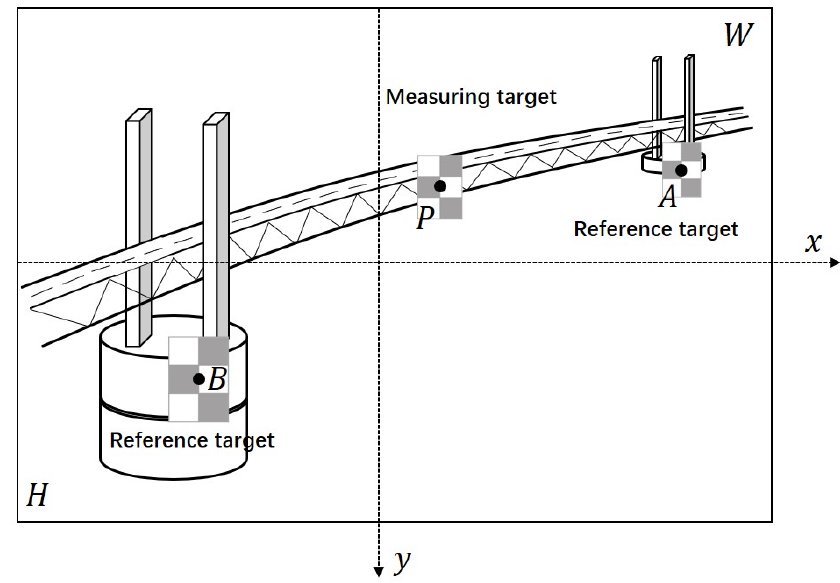
Figure 6. Measuring unit in the image plane.